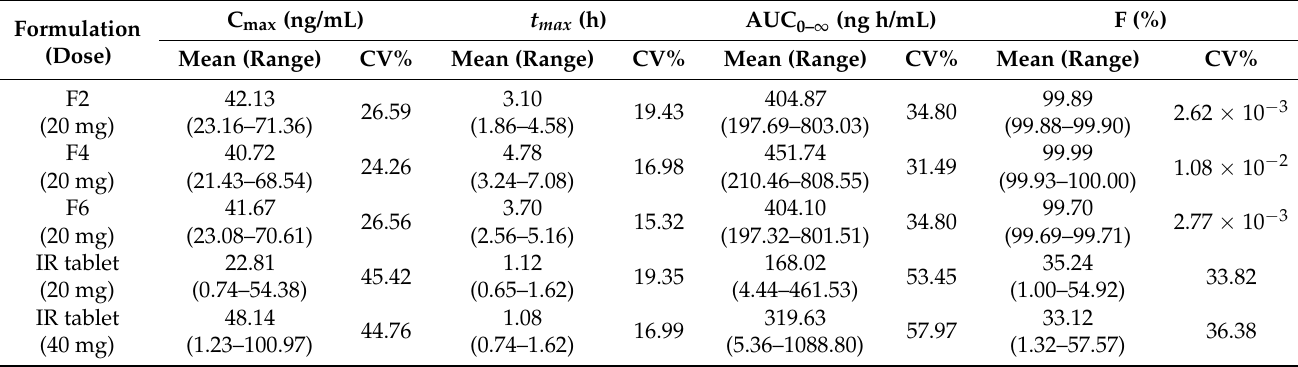
Table 6. Predicted pharmacokinetic parameters following single-dose administration of the tested 20 mg PRH buccal films and 20 mg and 40 mg IR tablets in 50 virtual subjects.